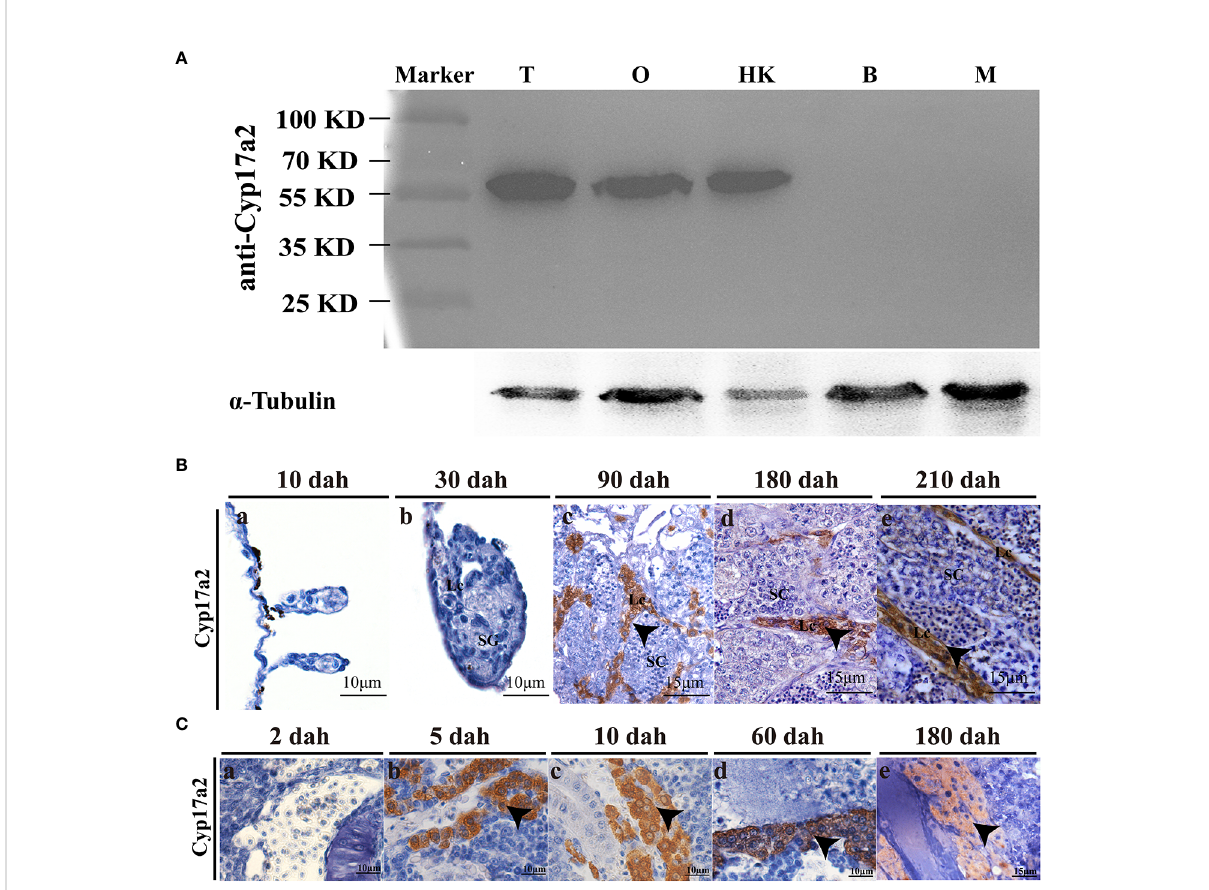
FIGURE 1 Expression pro fi le of Cyp17a2 in tilapia. (A) , The speci fi city of polyclonal antibody against Cyp17a2 (~60 KD) in the testis, ovary, head-kidney, brain, and muscle was veri fi ed by Western blotting. T, testis; O, ovary; HK, head-kidney; B, brain; M, muscle. (B) , Cellular localization of Cyp17a2 in the testes was detected by IHC. Cyp17a2 was expressed in the Leydig cells of the testis at 90, 180, and 210 dah. SG, spermatogonia; SC, spermatocytes; Lc, Leydig cells. (C) , Cyp17a2 expression in the head-kidneys was detected by IHC. Cyp17a2 positive signals were detected in the interrenal cells of the head-kidney at 5, 10, 60, and 180 dah. Arrowhead, positive signals of